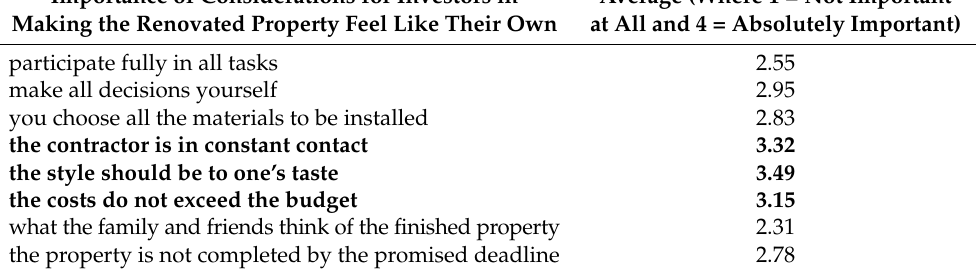
Table 4. Importance of factors affecting the psychological risk of the finished property (mean, where 1 = not at all important 4 = absolutely important).